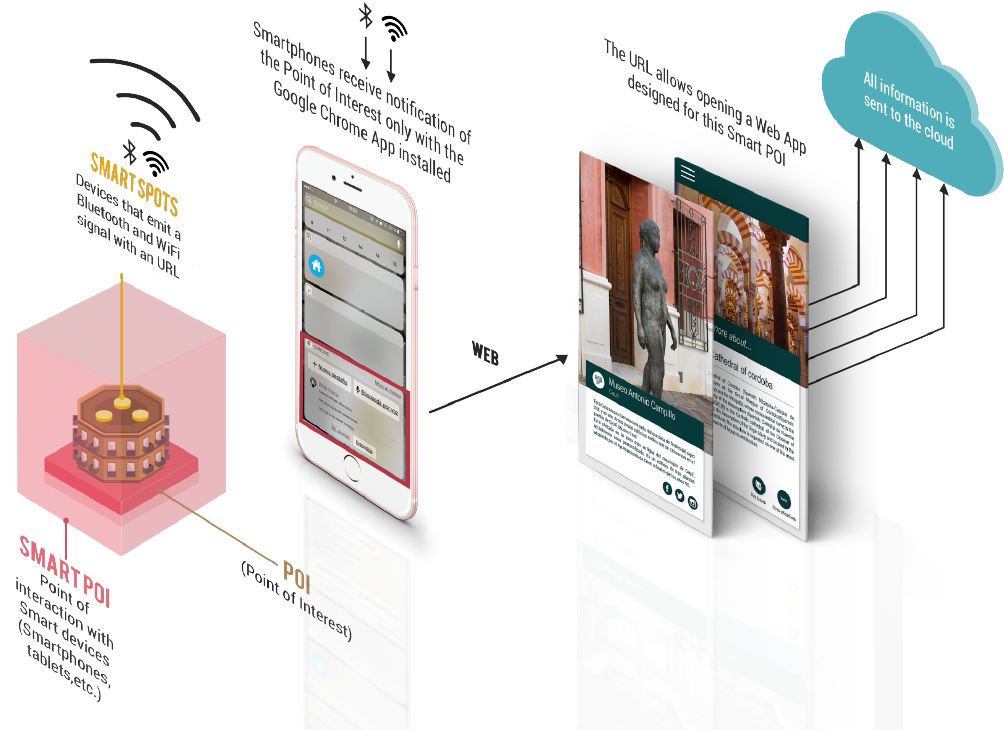
Figure 1. Schema of the relationship among Smart POI, Smart Spot, and